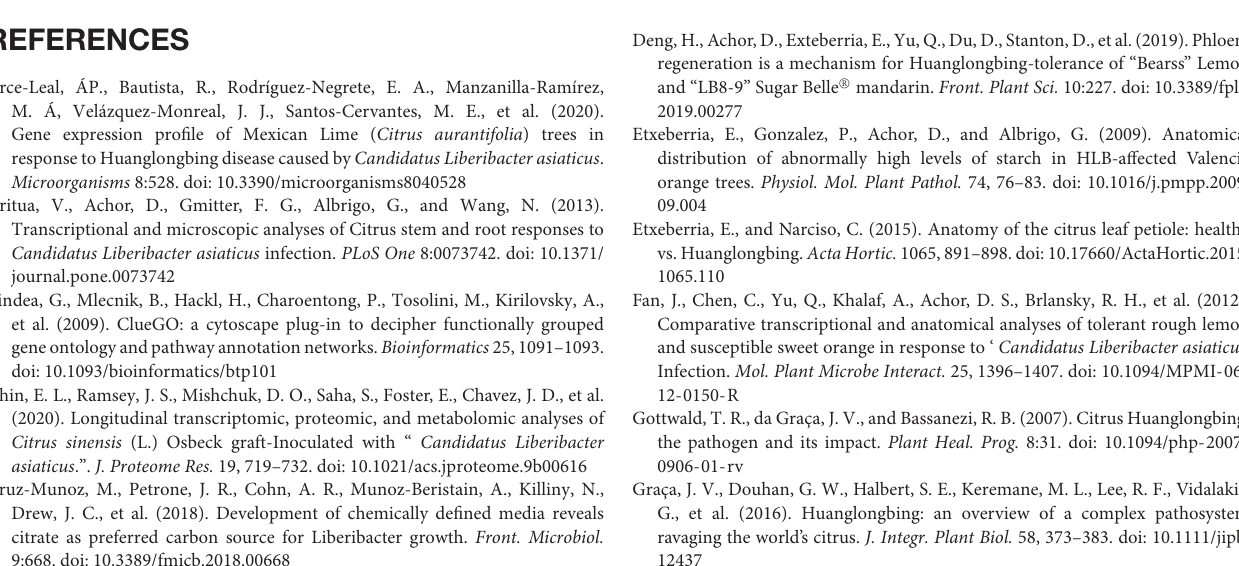
Supplementary Figure 3 | Regulation of carbohydrate metabolic pathway proteins by Ca. L. asiaticus infection in leaf petioles. (A) Asymptomatic stage (CI1 vs. MI1) and (B) symptomatic stage (CI2 vs. MI2). Red squares, significantly up-regulated proteins. Each colored square represents a single annotated gene in a particular pathway. Supplementary Figure 4 | Regulation of proteins involved in ubiquitin-dependent protein degradation by Ca. L. asiaticus infection in leaf petioles. (A) Asymptomatic stage (CI1 vs. MI1) and (B) symptomatic stage (CI2 vs. MI2). Red squares, significantly up-regulated proteins. Each colored square represents a single annotated gene in a particular pathway. There no significantly up-regulated proteins involved in ubiquitin-dependent protein degradation were observed in asymptomatic stage. Supplementary Figure 5 | Differentially accumulated proteins validated using qRT-PCR. (A) Results of qRT-PCR analysis of 16 DAPs selected from the comparison Ca. L. asiaticus-infected citrus plants with counterpart healthy. Error bars represent the SD of 3 independent experiments. (B,C) Correlation between results of relative gene expression from qRT-PCR and relative protein accumulation from proteomics analysis. FC: fold change. Supplementary Figure 6 | Western blotting analysis of psaDb (PS1 reaction center subunit III) and GBSS1 (granule-bound starch synthase 1) accumulation level in leaf petiole at asymptomatic stage (CI1 vs. MI1) and symptomatic stage (CI2 vs. MI2). 20 µ g extracted proteins were loaded into each lane, and three replicates were carried out. Supplementary Table 1 | The identification of peptides and proteins based on mass spectrometry proteomics data. Supplementary Table 2 | Differentially accumulated proteins (DAPs) in asymptomatic and symptomatic citrus petiole caused by Ca. L. asiaticus infection. Supplementary Table 3 | Gene ontology (GO) and Kyoto Encyclopedia of Genes and Genomes (KEGG) pathway enrichment analysis of differentially accumulated proteins (DAPs) in asymptomatic and symptomatic citrus petiole. Supplementary Table 4 | MapMan annotation of differentially accumulated proteins (DAPs) in asymptomatic and symptomatic citrus petiole. Supplementary Table 5 | Interaction network of differentially accumulated proteins (DAPs) analyzed by ClusterONE embedded in Cytoscape software in asymptomatic and symptomatic citrus petiole. Supplementary Table 6 | Information of primers used in this